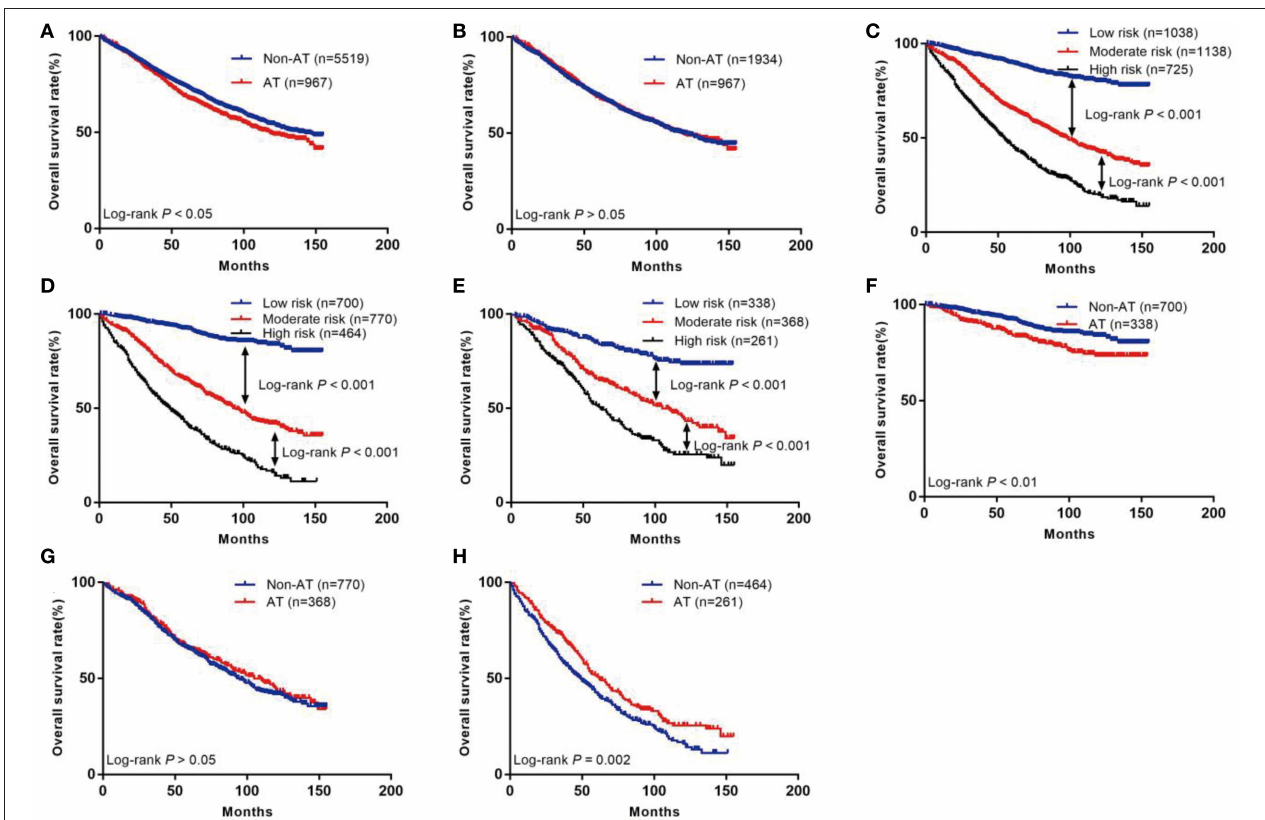
FIGURE 2 | The Kaplan–Meier curves of OS for patients in our study. (A) All patients; (B) Patients after PSM; (C) OS in different subgroups of all patients; (D) OS in different subgroups of non-AT group; (E) OS in different subgroups of AT group; (F) OS for patients with or without AT in low-risk group; (G) OS for patients with or without AT in moderate-risk group; (H) OS for patients with or without AT in high-risk group.